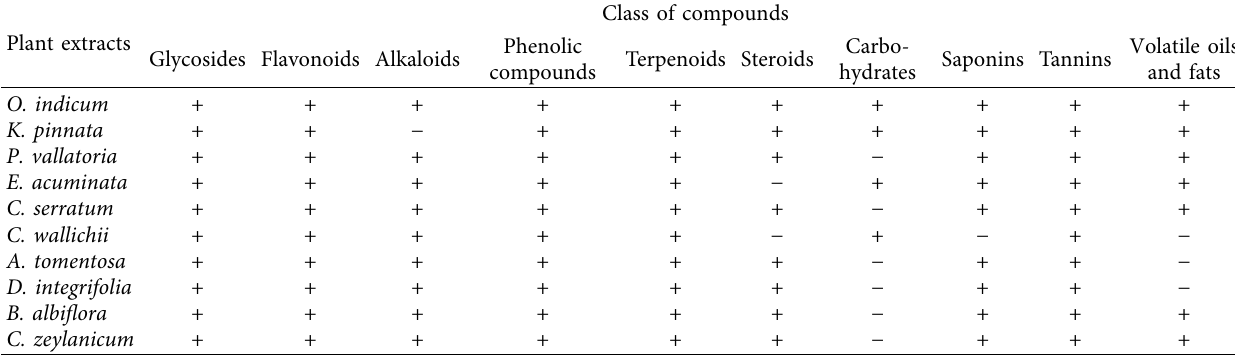
Table 3: Phytochemical screening of medicinal plants collected in Nepal. Plant